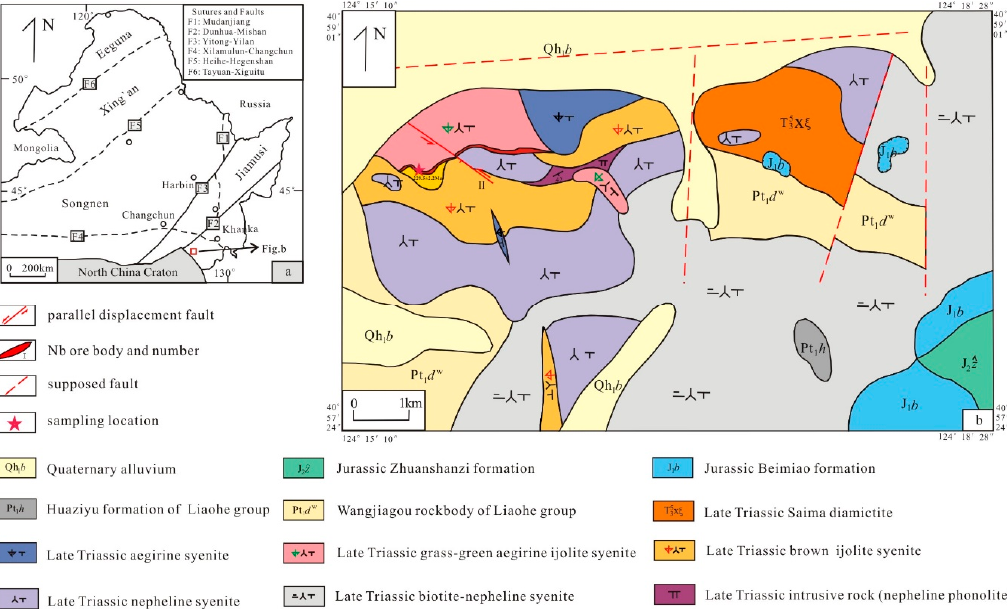
Figure 1. Geotectonic location map ( a ) and Geological sketch map ( b ) of Saima deposit in Fengcheng, Liaoning Province (modified from [5]).